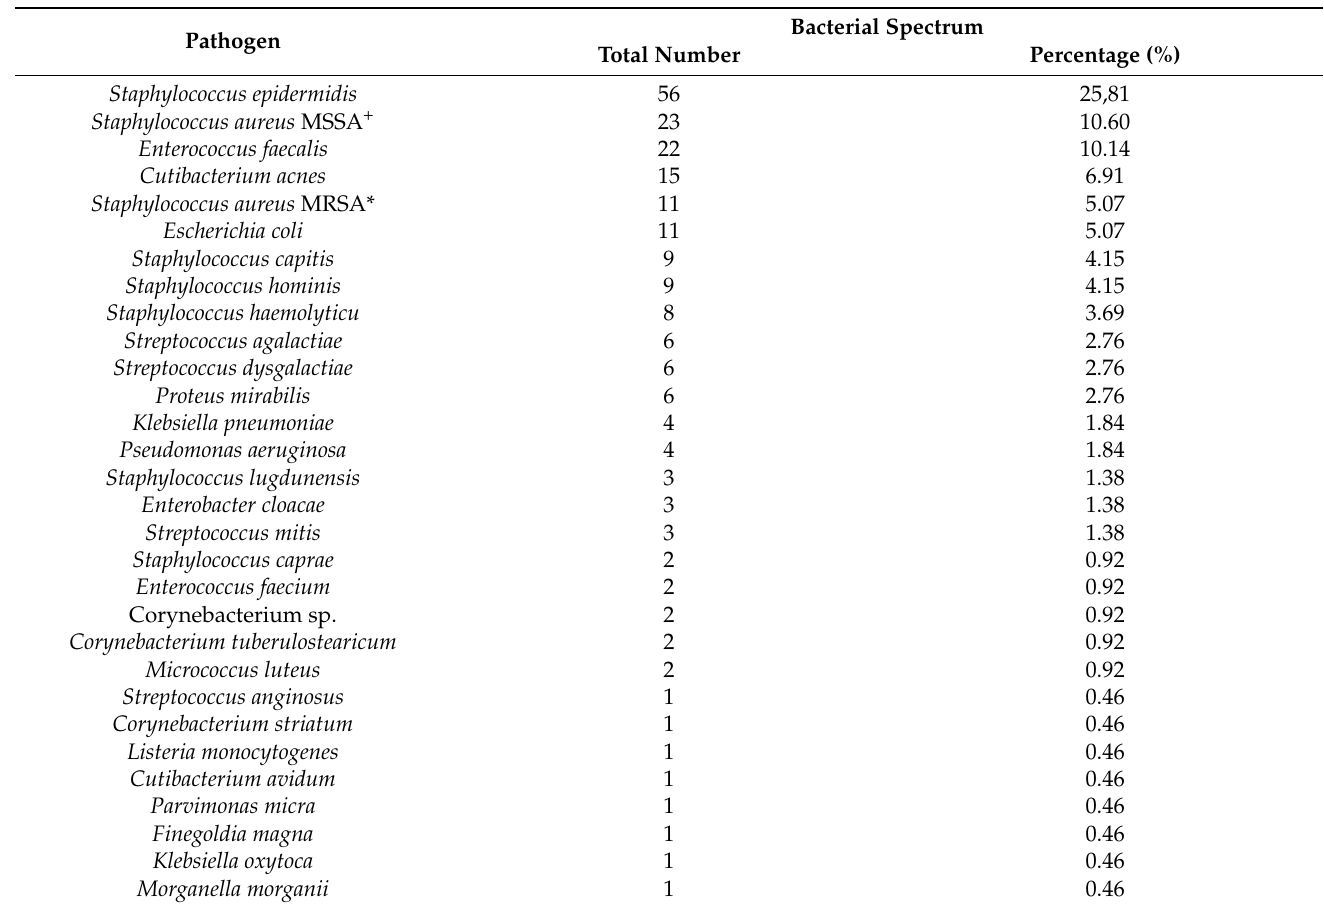
Table 1. Distribution of the isolated bacterial